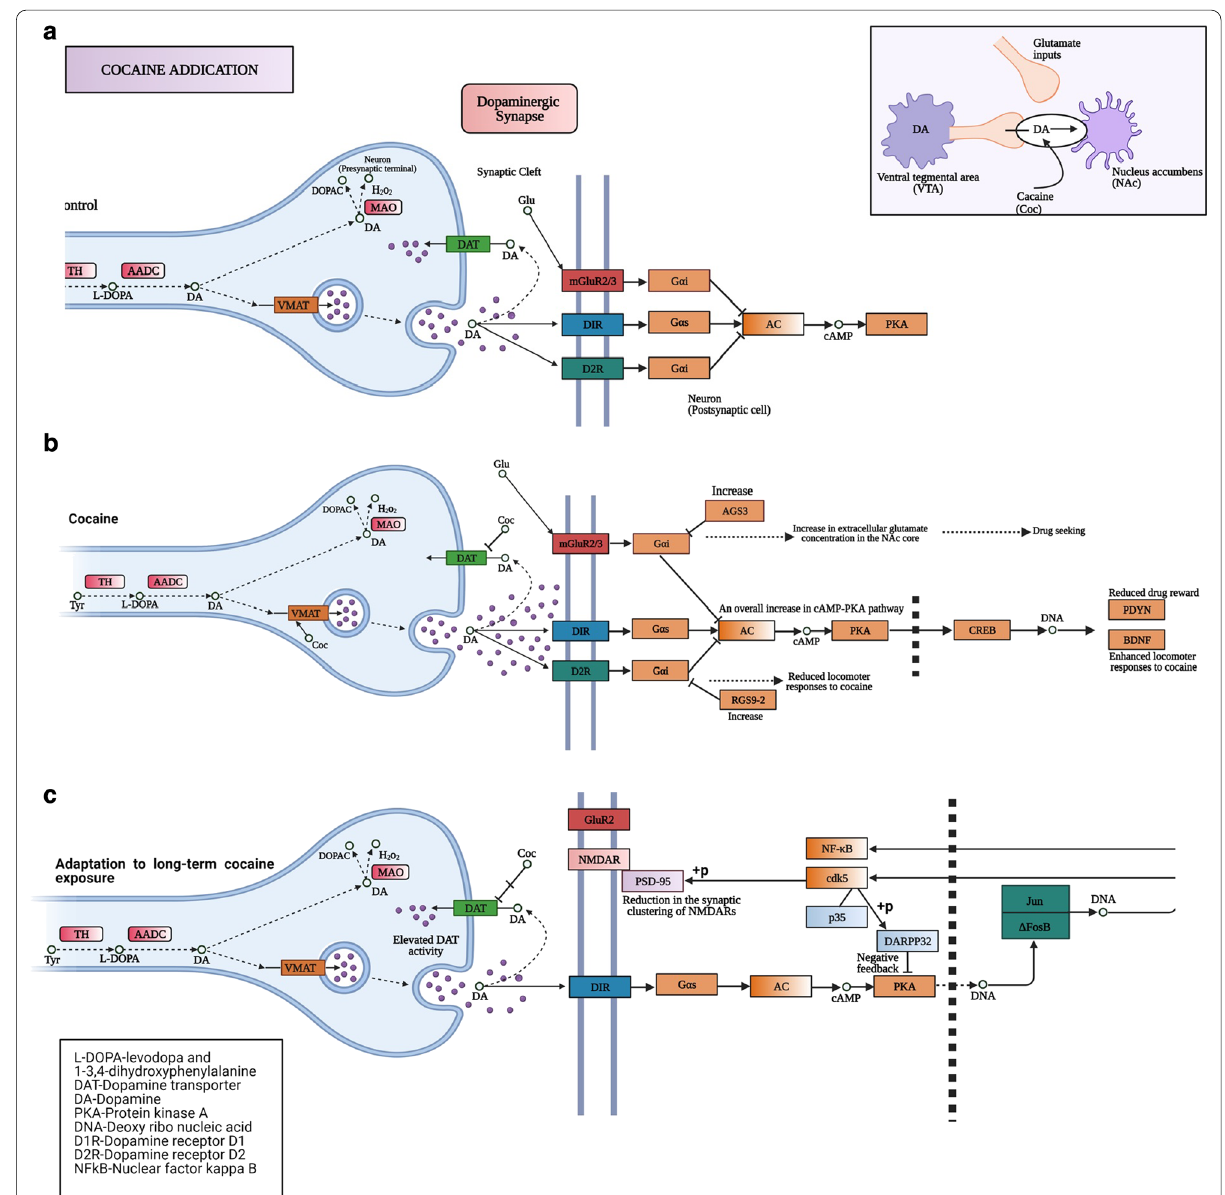
Fig. 1 Addiction and its related signalling pathway: Long-term exposure, on the other hand, causes the brain to adapt to a certain level of dopamine (DA) that can bind to the dopamine transporter (DAT), which aids in the transit of dopamine back to the nerve terminal. To achieve the same level of enjoyment, greater doses are required. When the PKA signalling pathway is activated via the D1R receptor, FosB is activated, which plays a role in the development and maintenance of addiction. The activation of this cdk5 as well as the activators p35 and DARPP32 causes the protein Postsynaptic density protein 95 (PSD 95) to be activated, resulting in a reduction in NMDAR synaptic